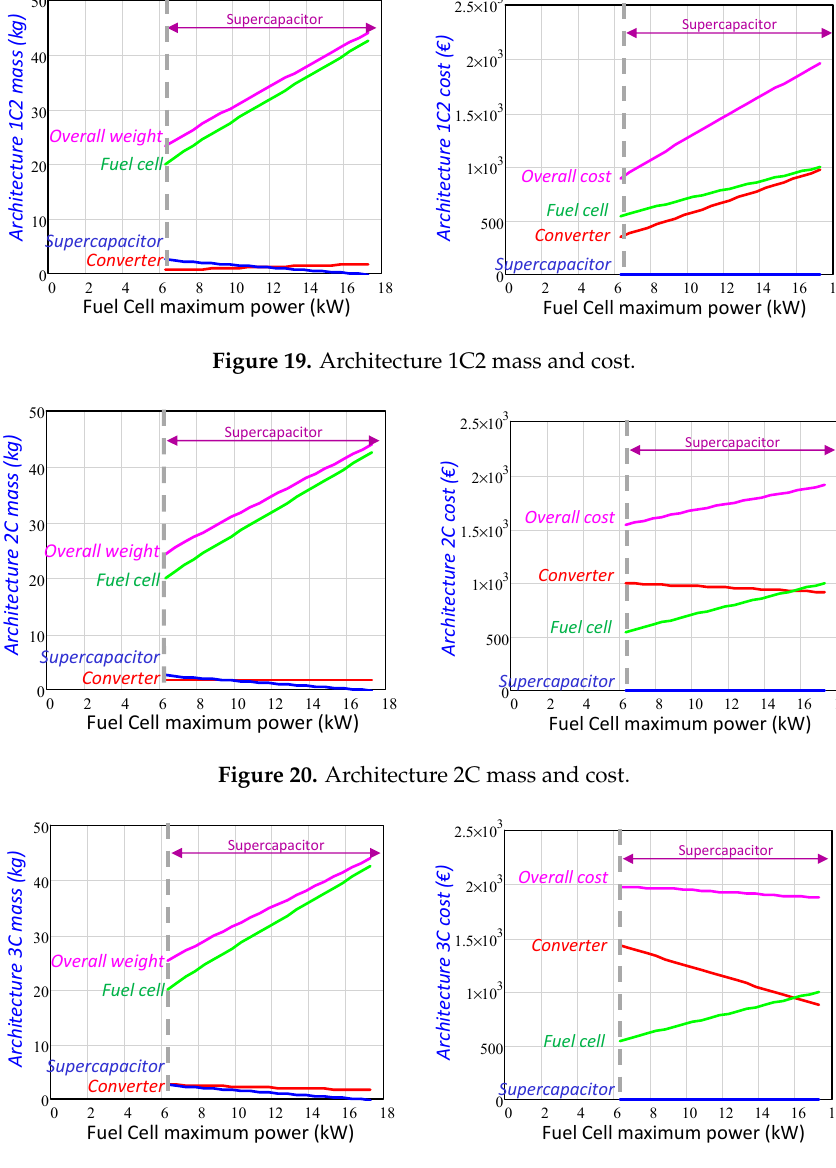
Figure 21. Architecture 3C mass and Figure 21. Architecture 3C mass and cost. Figure 21. Architecture 3C mass and cost. Figure 21. Architecture 3C mass and cost. Figure 21. Architecture 3C mass and cost.